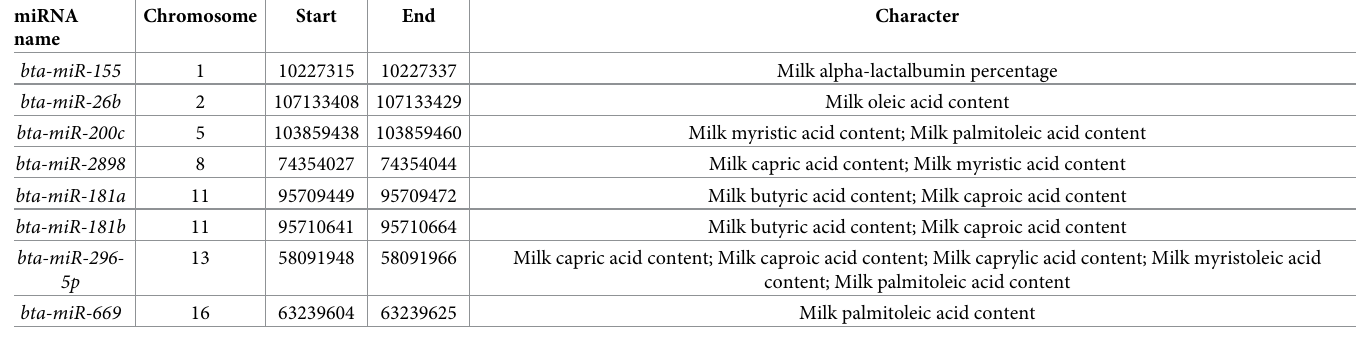
Table 4. Location of nutriregulated miRNAs in QTL associated with milk production and